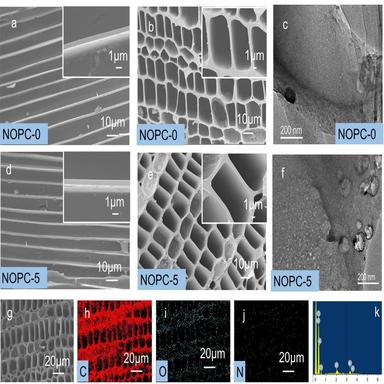
(a, b, d, e) SEM, and (c and f) HRTEM images of as-prepared (a-c) NOPC-0, (d-f) NOPC-5; among which a and d are the longitudinal section, b and e are the horizontal cross-section. (g-k) Elemental mapping of (h) C element, (i) O element, (j) N element, and (k) EDX spectra for the NOPC-5 sample.